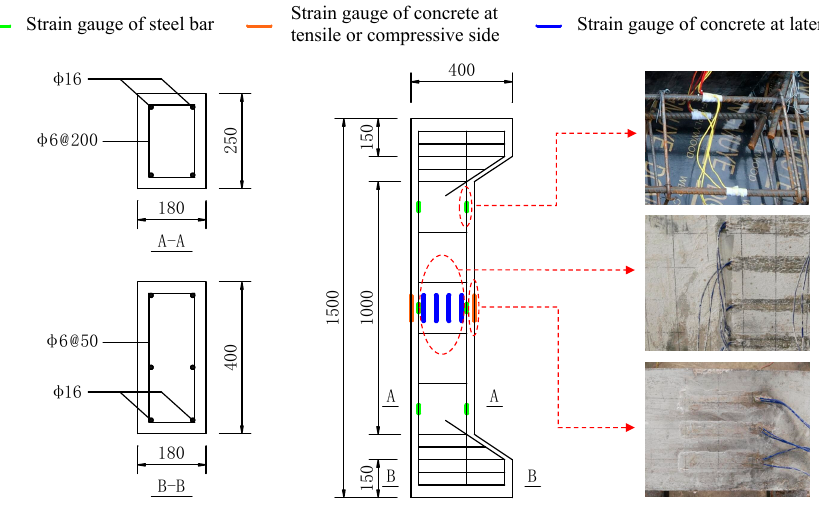
Figure 6. Design of the column specimens (unit in mm).